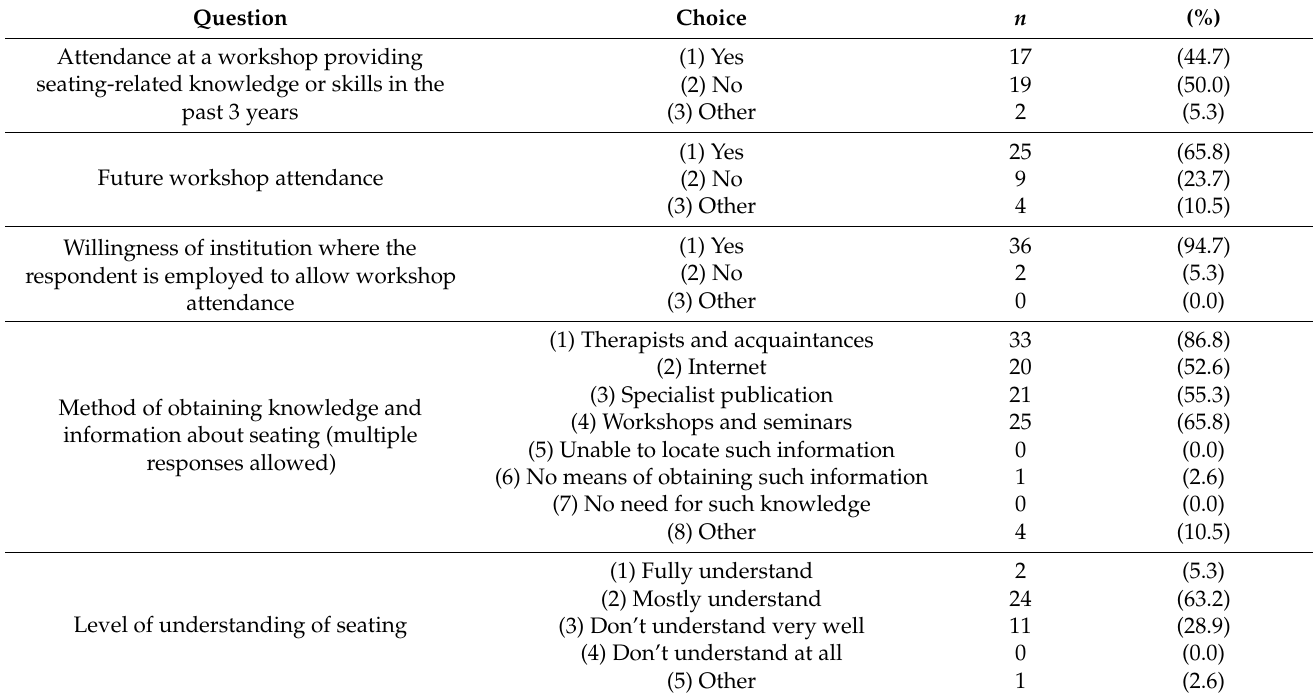
Table 5. General questions about seating ( n =